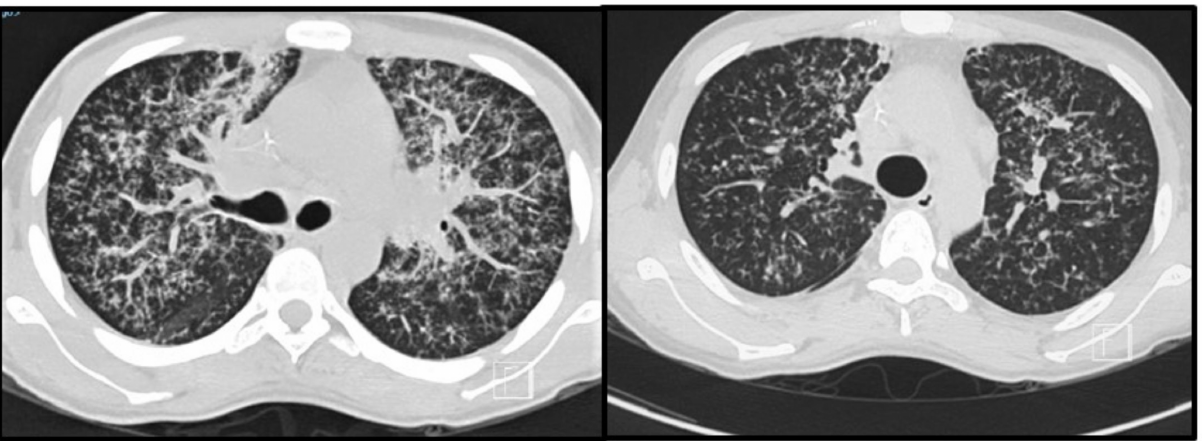
Figure 2. Pulmonary images of a 19-year-old male patient with subacute pulmonary coccidioidomyco- sis: axial thoracic CT showing bilateral peribronchovascular and perilymphatic nodules in both